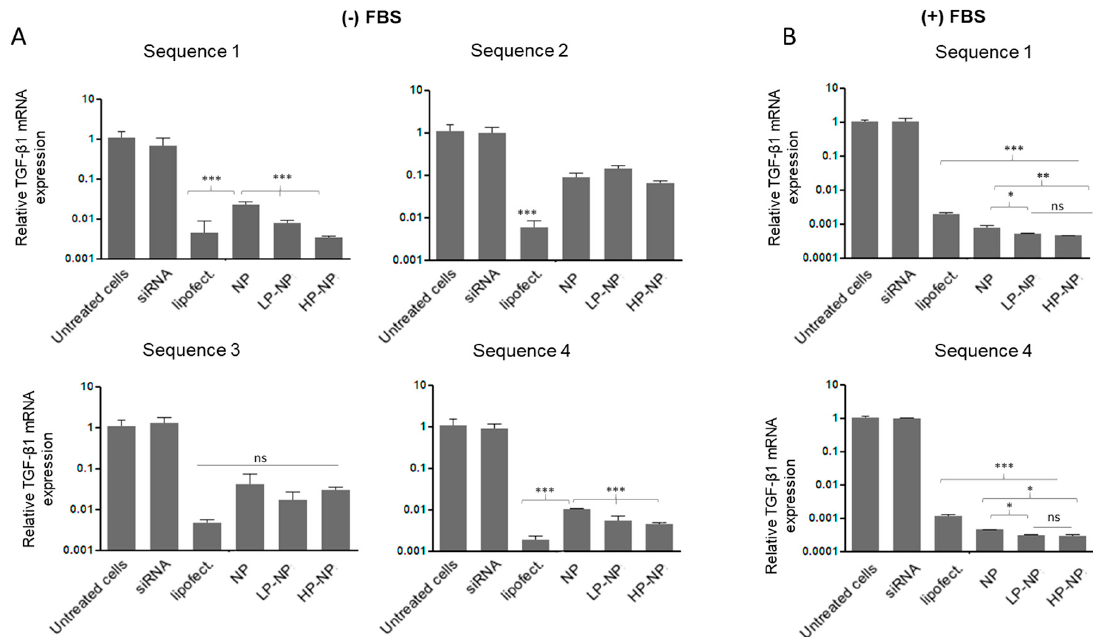
Figure 4. Transforming growth factor-beta (TGF- β 1) gene silencing in GRX cells as determined by RT-qPCR (n = 3). Cells were treated with different sequences of TGF- β siRNA in free form (siRNA), transfected with Lipofectamine 2000 (lipofect.), encapsulated in unmodified NPs (NP), LP-NPs and HP-NPs in ( A ) serum-free cell culture medium and ( B ) medium supplemented with 10% fetal bovine serum (FBS). Statistical analysis was performed by GraphPad InStat software using a one-way analysis of variance test (ANOVA), where (*) p < 0.05, (**) p < 0.01 and (***) p < 0.001.